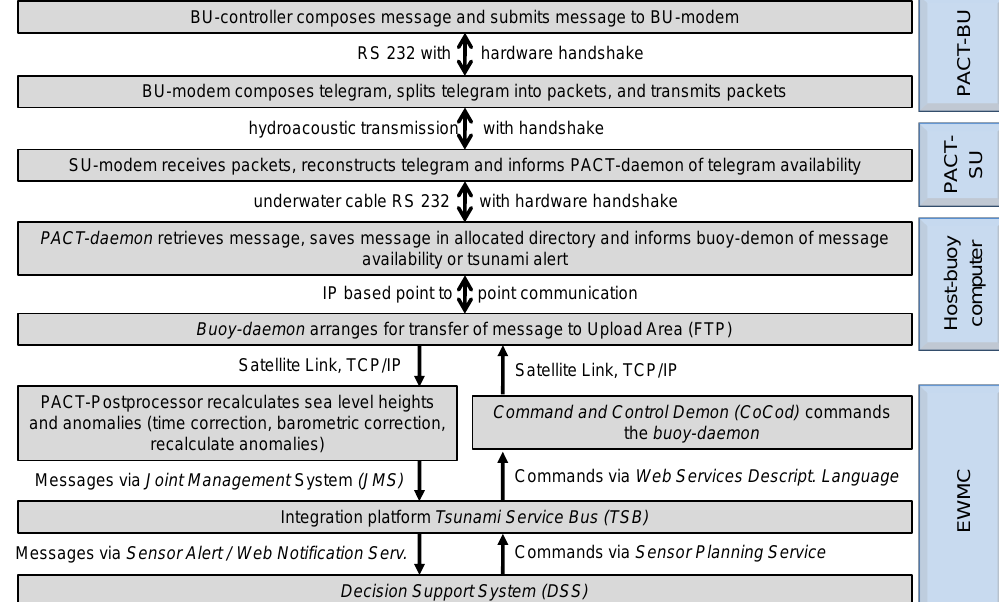
Fig. 2. Schematic of data flow of PACT system. Messages are transferred top-down, i.e. originate at the PACT-BU (top level) and terminate at the data support system (DSS) of the tsunami early warning centre (TEWC). Commands may be issued in the TEWC and are transferred bottom-up to the PACT-BU, where they might toggle the BU’s state. All communication links are secured via handshake protocols.